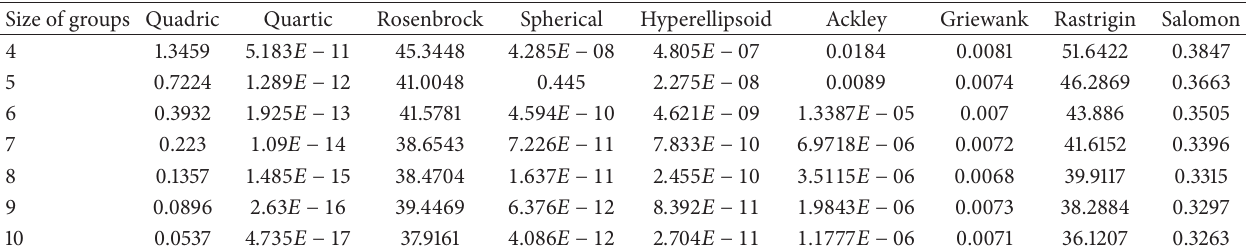
Table 8: Average results on the experiments involving the size of group.